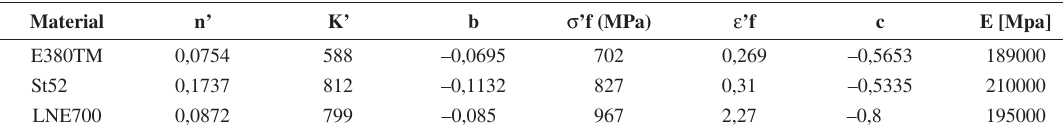
Table 1. Material fatigue data for the used steels.